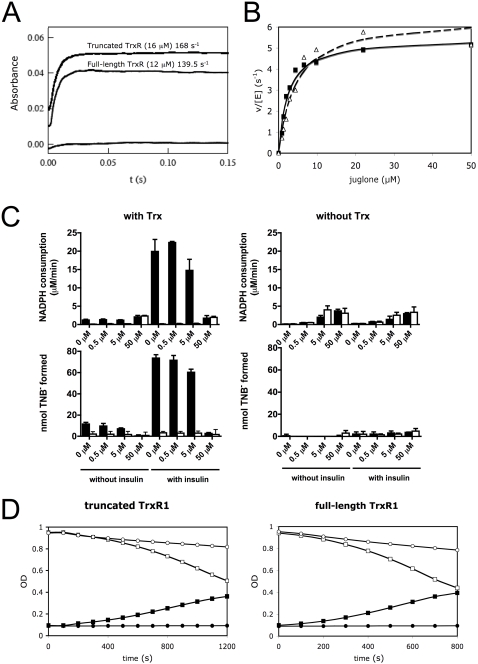
Both SecTRAPs and TrxR1 are efficient in reducing juglone and thereby produce superoxide.In (A) the formation of FAD-reduced disulfide charge transfer complex by NADPH (80 µM) in a SecTRAP preparation (truncated TrxR1, 16 µM subunit) and full-length TrxR1 (12 µM subunit) was analyzed with stopped-flow spectroscopy at 540 nm, showing similar kinetics for both enzymes. In (B) Michaelis-Menten kinetics for both full-length (filled symbols) and truncated (open symbols) TrxR1 using juglone as a substrate is demonstrated. In (C) it is shown that Trx1 and juglone compete for the reduction by full-length TrxR1 (filled bars) but that truncated TrxR1 (open bars) can only use juglone and not Trx1 as a substrate. This is illustrated from the initial NADPH consumption rate (0–200s) followed at 340 nm with or without Trx1 and insulin (upper panels). After 30 min of reaction, the number of exposed free thiols was determined (lower panels) in order to estimate to which extent the electrons from the NADPH oxidation were passed on to Trx1 and subsequently to insulin. The juglone concentration is indicated at the x-axes and each bar represents the mean±S.D. of three measurements. In (D), the reduction of juglone (5 µM) catalyzed by 10 nM SecTRAP (truncated TrxR1, left panel) or full-length TrxR1 (right panel) is shown following the consumption of NADPH (initial concentration 250 µM) by the decrease in absorbance at 340 nm (open symbols). Concomitantly, superoxide formation was detected at 480 nm with the adrenochrome method using 2 mM epinephrine (filled symbols). The formation of adrenochrome was completely inhibited by addition of 5 U SOD (circles), which also reduced the elevated NADPH consumption seen upon addition of only epinephrine (squares).